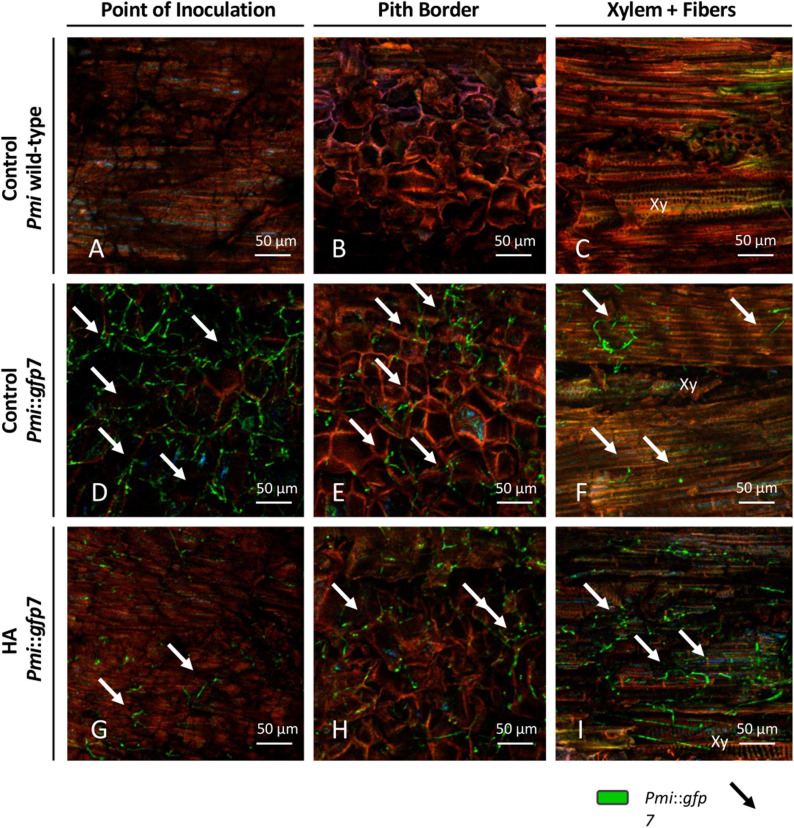
CLSM observations (four repetitions) of grafted vines samples cv. Chardonnay on Kober 5BB rootstock (six technical replicates), harvested 15 weeks post Phaeoacremonium minimum (Pmi) inoculation. Images are referred to the longitudinal section of the inoculation site (3 cm above and 3 cm below) at the rootstock level and presented according to the strain, Pmi wild-type (A–C) and Pmi::gfp7
(D–F), the plant tissue, point of inoculation (A,D,G), pith border (B,E,H) and xylem with fibers (C,F,I), and the HA treatment (G,H)
versus the untreated controls (A–F). Xy: xylem.